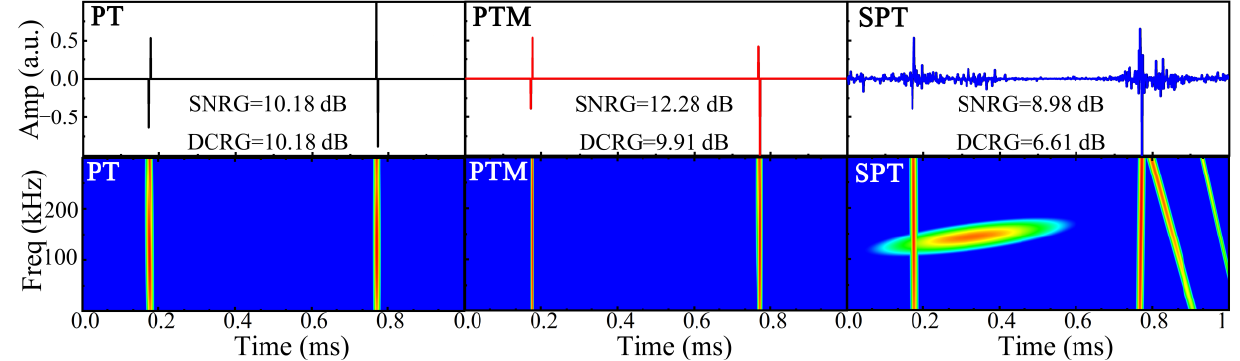
Figure 10. Optimized synthesized UGW signals processed by FBR-RC-SSP.